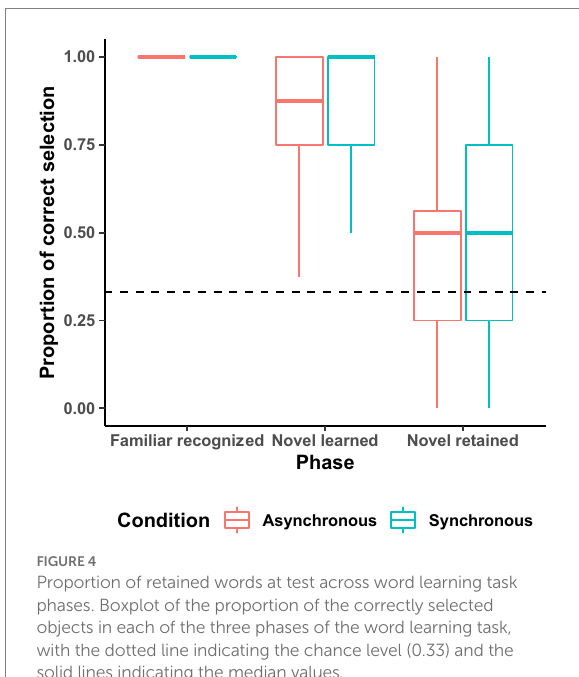
FIGURE 4 Proportion of retained words at test across word learning task phases. Boxplot of the proportion of the correctly selected objects in each of the three phases of the word learning task, with the dotted line indicating the chance level (0.33) and the solid lines indicating the median